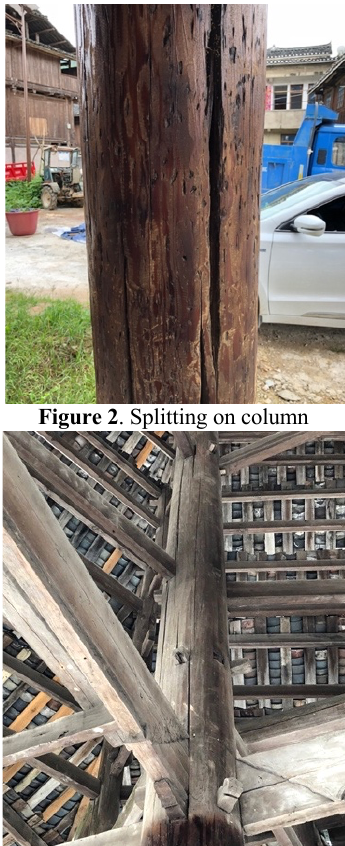
Figure 3 . Splitting along the connection of column and tie-